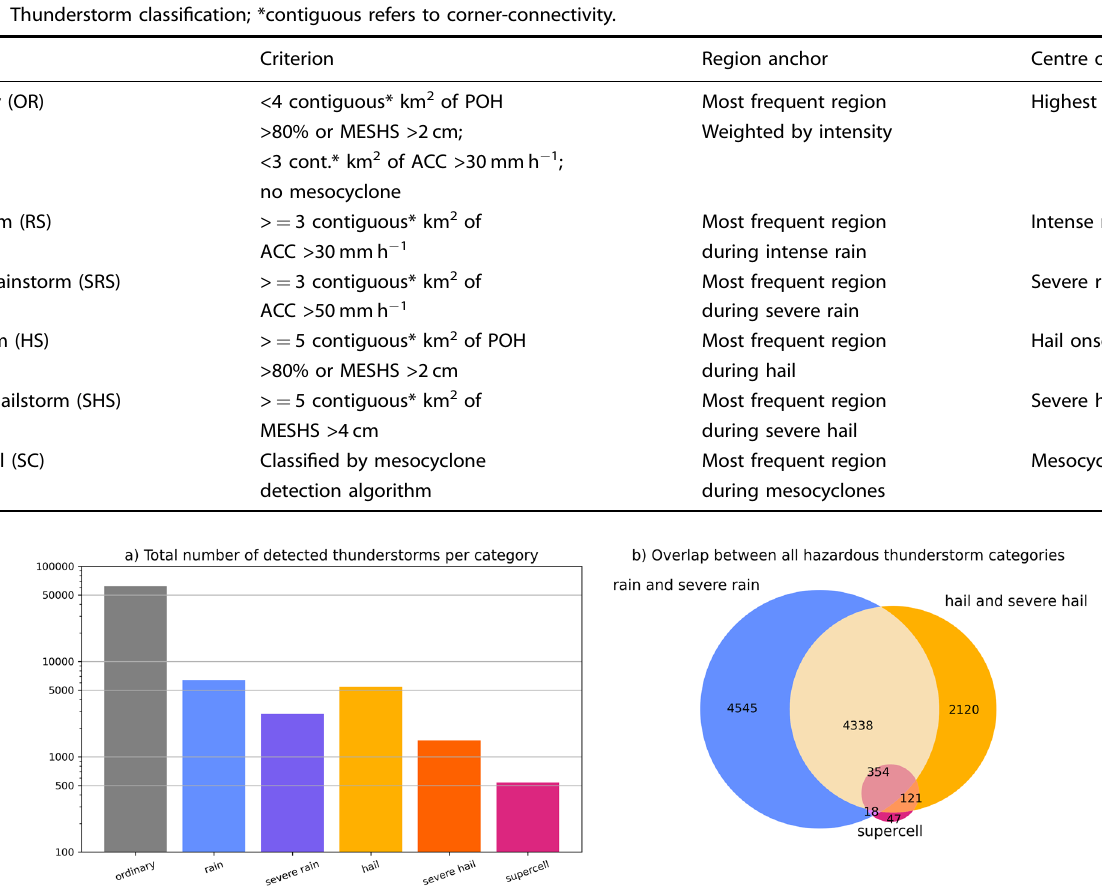
Fig. 2 Overall occurrence of different convective types. a Number of detected storms per category, b overlap between hazardous thunderstorm categories — rain and severe rain, as well as hail and severe hail are each categorised together, over the entire 6-year data set.